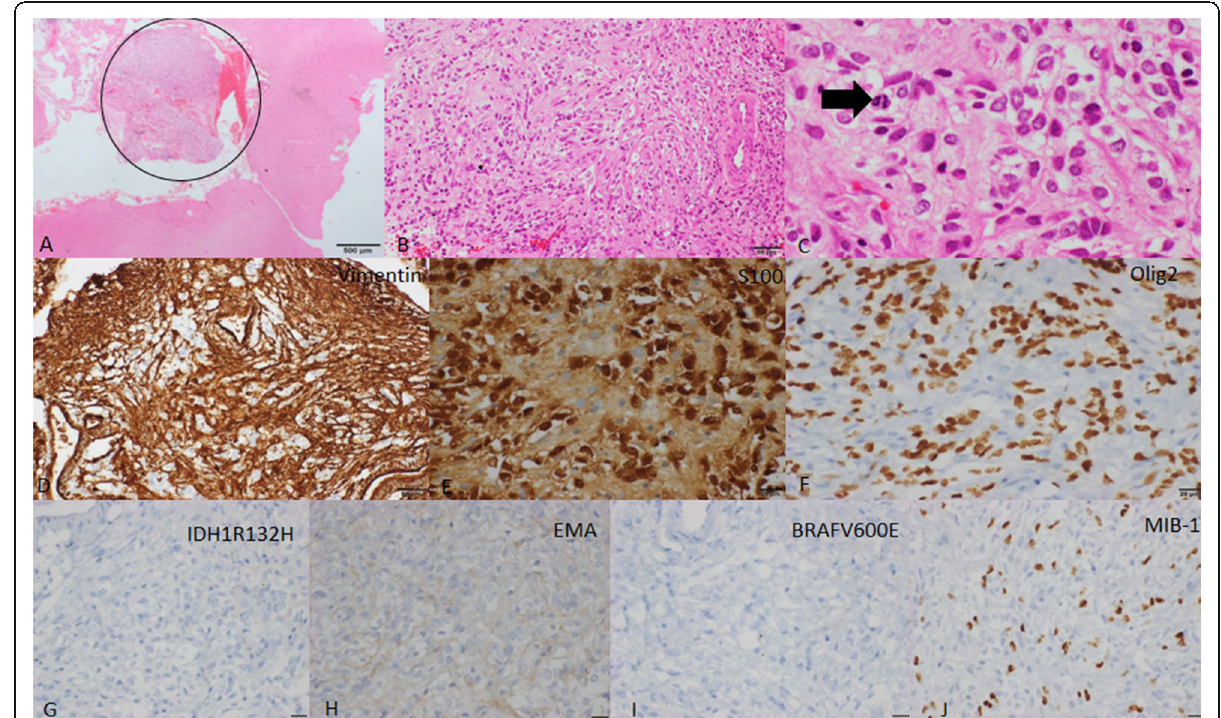
Fig. 6 Histopathological features of the leptomeningeal biopsy specimen. A Hematoxylin & eosin stain photomicrograph of the leptomeningeal biopsy specimen shows a small nodule of tumor within the tumor as shown with a circle. B Hematoxylin & eosin stain photomicrograph of the tumor region shows glial cells with eosinophilic clear cytoplasm. C Hematoxylin & eosin stain of the tumor shows mitotic figures within the glial cells as depicted with the help of the arrow. D Photomicrograph of the tumor with immunoperoxidase shows positivity for vimentin. E Photomicrograph of the tumor with immunoperoxidase shows positivity for S-100. F Photomicrograph of the tumor with immunoperoxidase shows positivity for Olig2. G Photomicrograph of the tumor with immunoperoxidase shows immunonegative response for IDH1R132H. H Photomicrograph of the tumor with immunoperoxidase shows immunonegative reaction for EMA. I Photomicrograph of the tumor with immunoperoxidase shows immunonegativity for BRAFV600E. J Photomicrograph of the tumor with immunoperoxidase shows moderate proliferation of the tumor cells